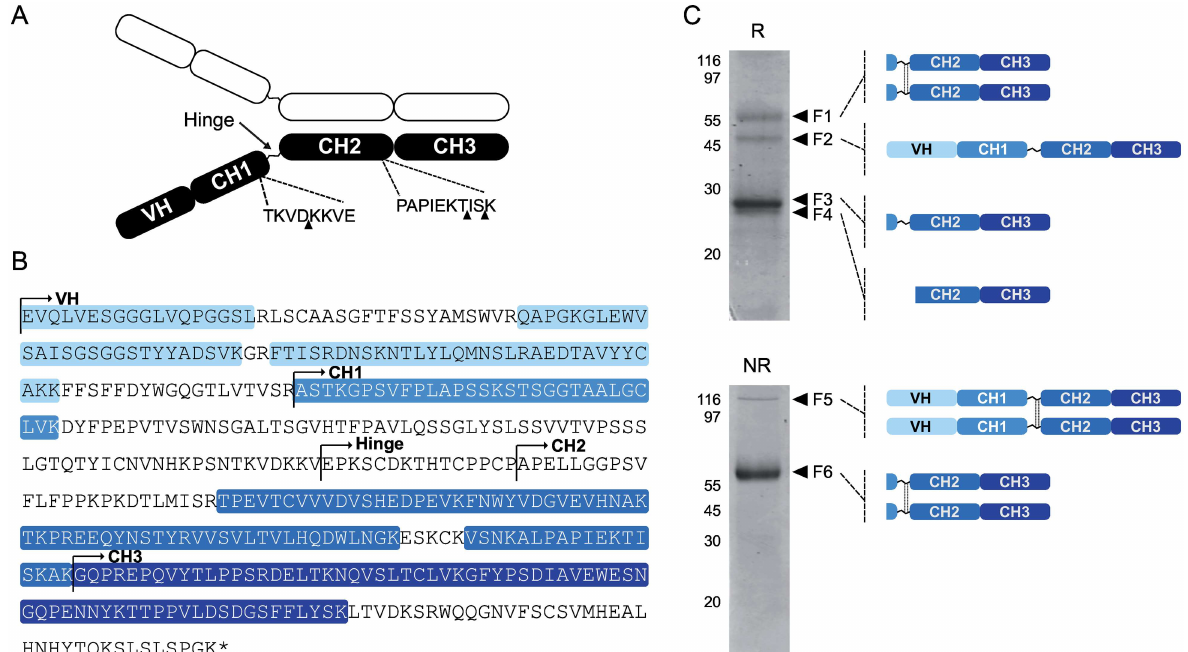
Fig 5. MS/MS characterization of H10 heavy chain fragments isolated from Sl CYS8-expressing plants. A: Schematicdiagram for the H10 heavy chain, highlightingthe variableVH domain, the constant domainsCH1, CH2 and CH3, and the hinge regionlinkingCH1 to CH2. Black arrows point to the most important cleavagesites of H10 heavy chain in the N . benthamiana leaf cell secretory pathway as recently inferred by Hehleet al. [20]. B: Amino acid sequenceof H10 heavy chain. Peptide sequencesidentifiedby LC-MS/MS ( see panel C) are shaded in blue. C. Correspondence betweenMS/MS uniquepeptidedata and heavy chain domainfragments or assemblies detected on Coomassie blue-stained gels followingSDS-PAGE in reducing (R) or non-reducing (NR) conditions. Six fragments (bands F1 to F6) detected followingelectrophoresis and Coomassie blue stainingwere excised manually and submitted to LC-MS/MS analysis. Schematicrepresentations on the right indicate the composition of each fragment basedon MS/MS data. Sequence details for identified uniquepeptides are given in S1